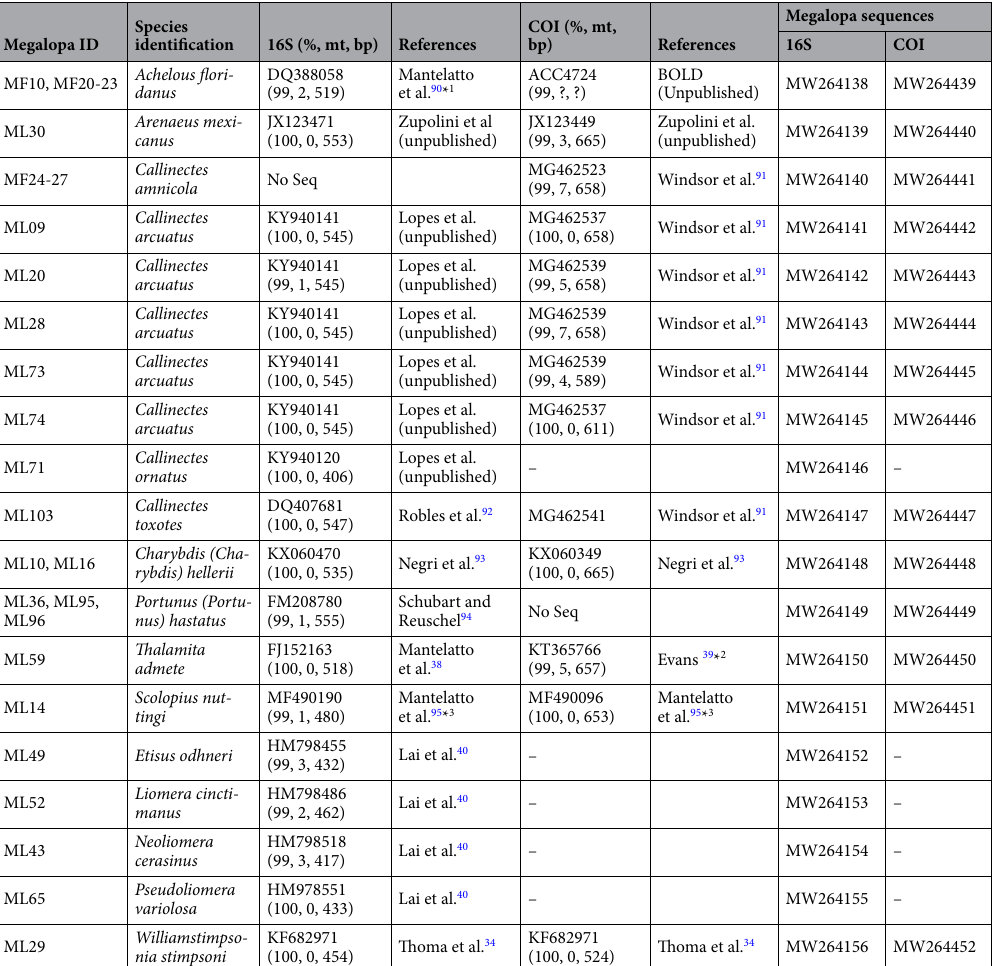
Table 1. Identification of the megalopas collected in the in the MALASPINA 2010–2011 and MAF 2015 cruises based on 16S and COI barcodes. Indicating: (1) species identified, (2) accession codes of the Genbank and BOLD sequences (when there is more than one sequence it was selected the longest), including in brackets: % of similarity with megalopa sequence, divergence (as number of mutations) and number of base pairs compared, and (3) accession codes of the megalopas sequences in Genbank. ML and MF refer megalopa codes from MALASPINA 2010–2011and MAF 2015 expeditions, respectively; mt mutations, – sequence no obtained, No Seq no sequence fit > 90% in databases, * 1 , as Portunus floridanus ; * 2 , as Thalamita gatavakensis ; * 3 , as Micropanope